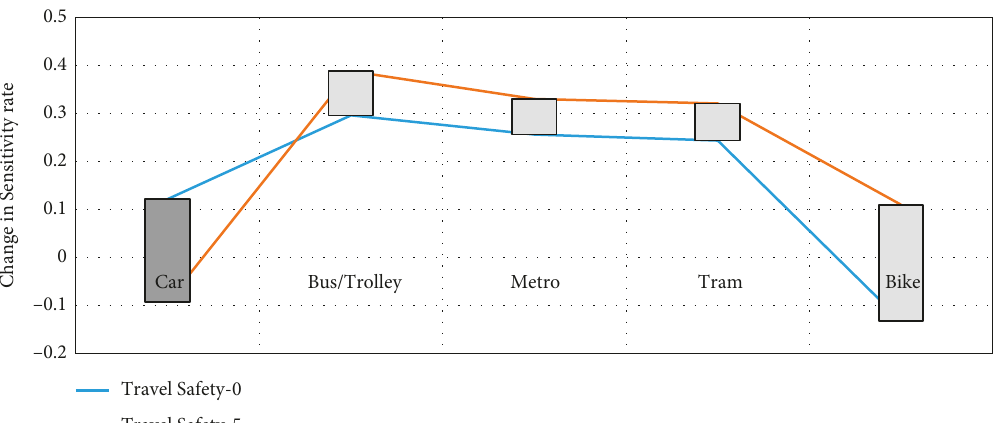
Figure 10: The comparison between the coefficients of the mode choice based on changing travel